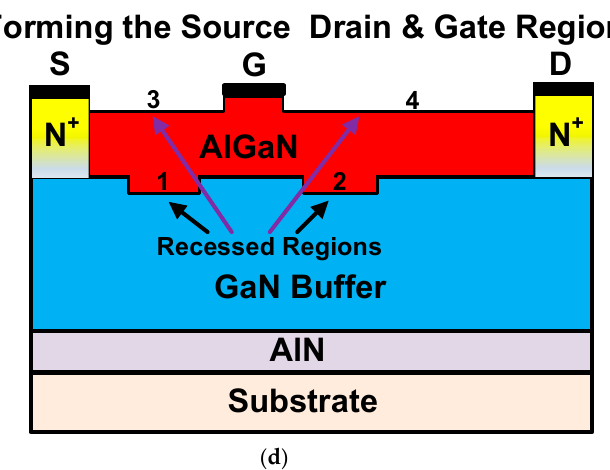
Figure 10. Key processes to fabricate the HGMRB HEMT. ( a ) Reactive ion etching is used to form the two recessed regions 1 and 2. ( b )The AlGaN barrier layer is grown by molecular beam epitaxy. ( c ) Reactive ion etching is used to form the two recessed regions 3 and 4, and a high gate is obtained. ( d ) Source, drain, gate, and ohmic contact processes are formed .